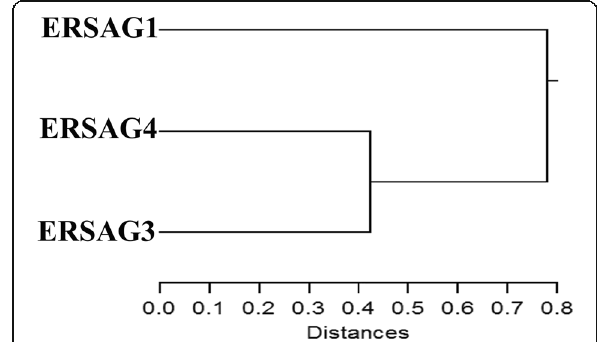
Fig. 4 Phylogenetic tree of the three Heterorhabditis sp. isolates based on ISSR